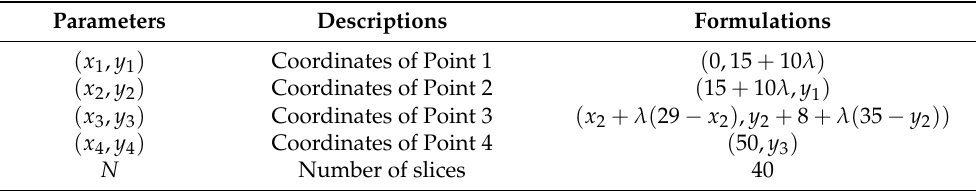
Table 2. Coordinates of the four points used to create the geometry of the slope image data.